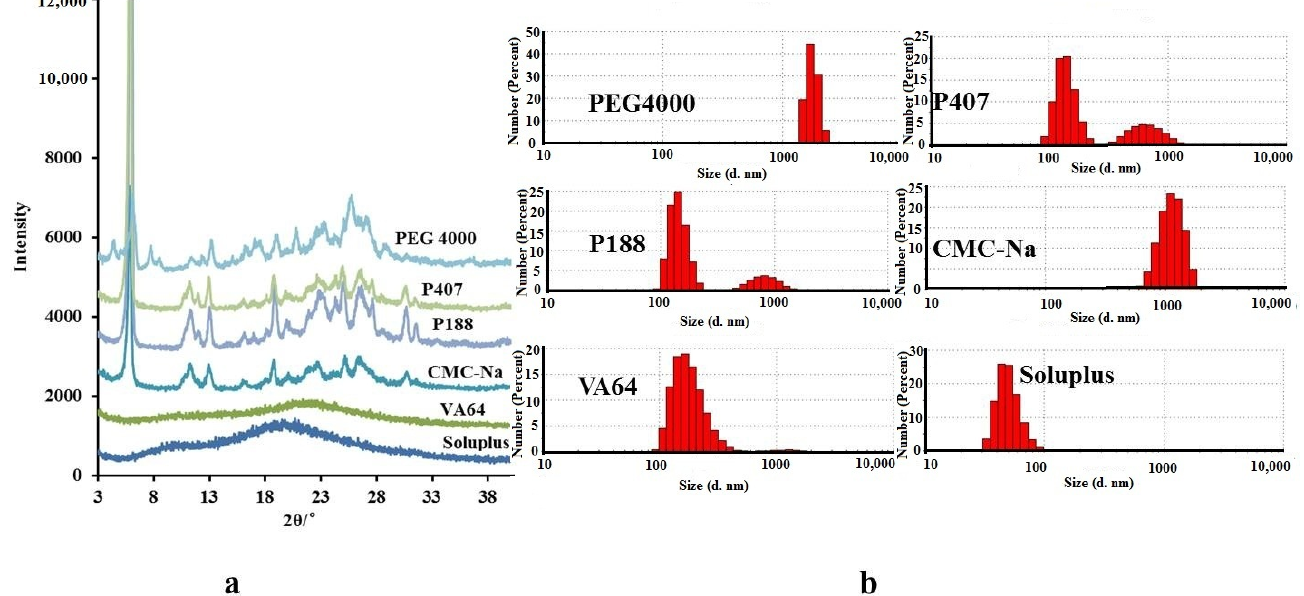
Figure 4. XRPD patterns ( a ) and PSD spectra ( b ) of AINs prepared with different polymers. AINs: amorphous icaritin nanoparticle; PSD: particle size distribution; XRPD: X-ray powder diffraction.